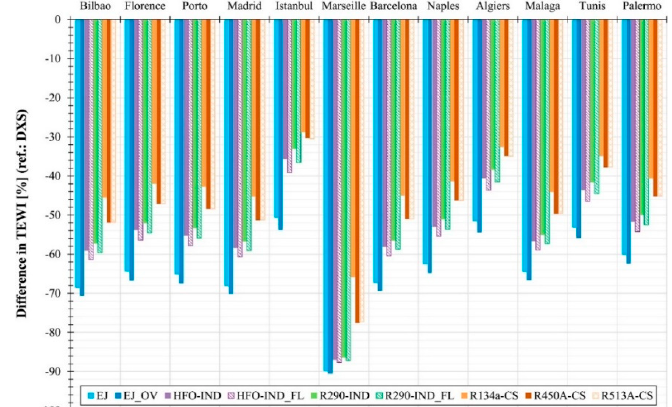
Figure 14. Difference in TEWI among various supermarket refrigeration solutions (DXS: R404A unit;